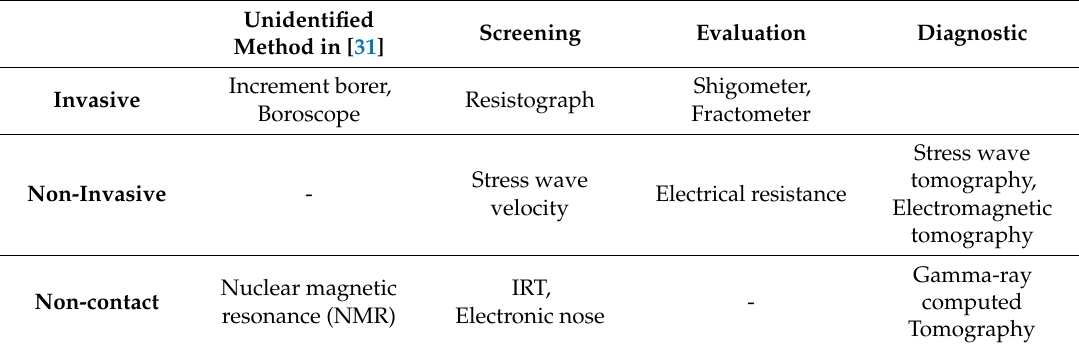
Table 1. Classification of instruments for detecting deterioration in trees (adapted from Reference [31]).